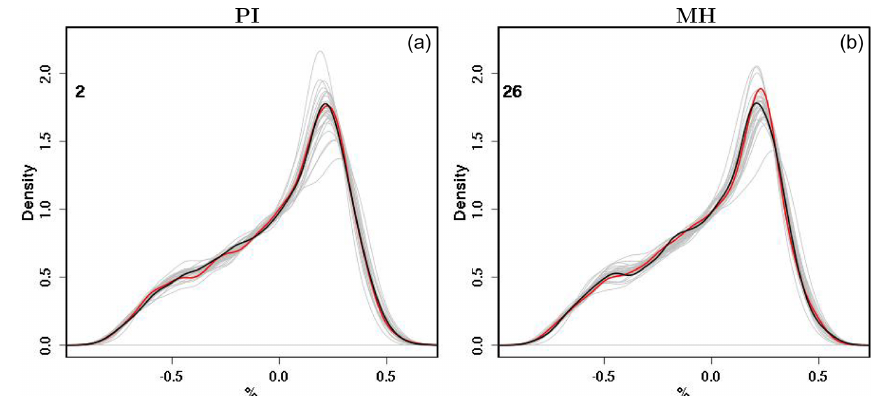
Figure 7. Probability distribution functions of daily mean anomalies of total cloud cover calculated for the different ensemble realizations for the PI (a) and the MH (b) periods, for a randomly selected grid point in subregion 8 of Fig. 2. The PDF of the reference run, considered as the “nature” state, is highlighted in black. The realization with the minimum MAE with respect to the PI reference run is highlighted in red in both panels. Gray lines represent the remaining members of the ensembles for the two